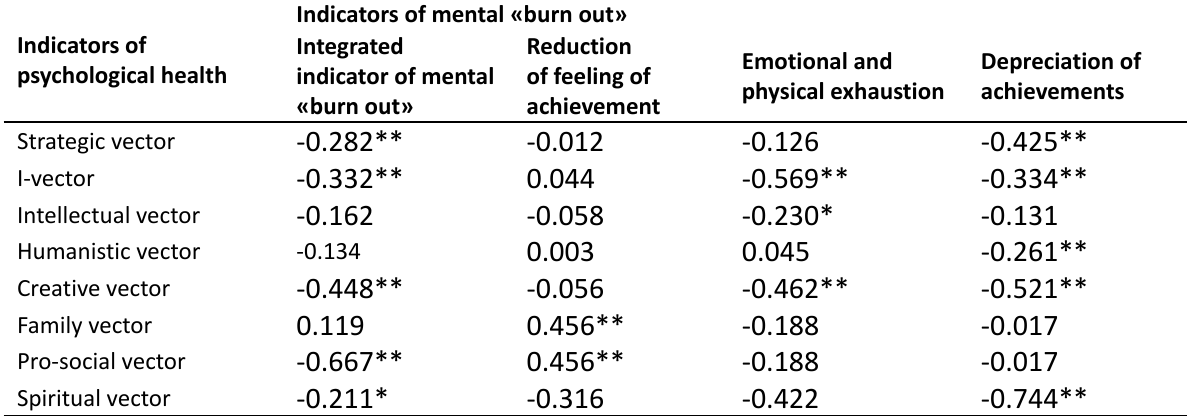
Table 3. Correlation coefficients between indicators of mental “burn out” and psychological health in low qualification athletes